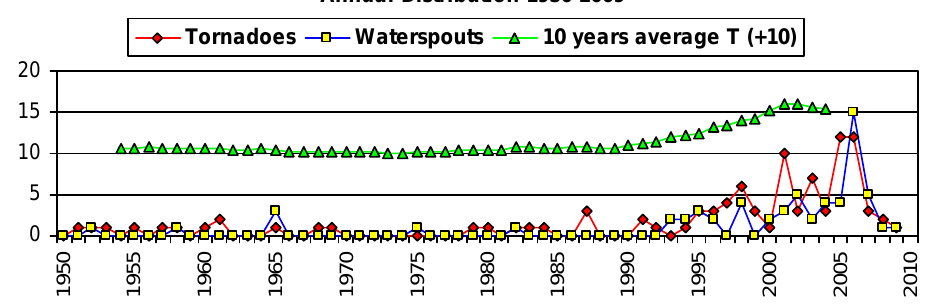
Figure 8. Temporal evolution of the annual number of tornadoes and waterspouts recorded in the period 1950-2009.